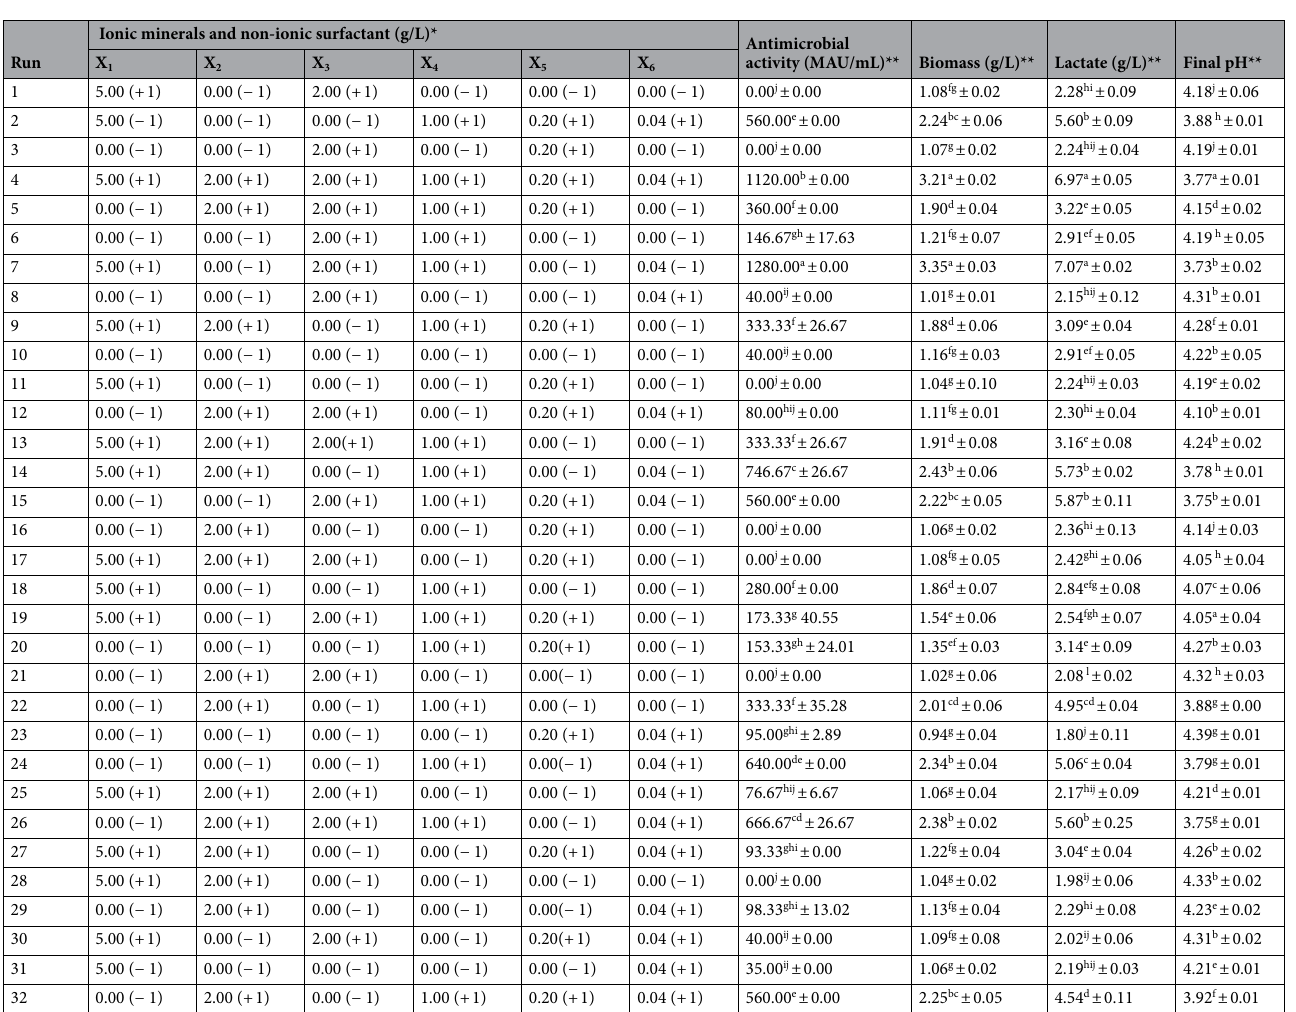
Table 4. FFD matrix with coded and real values of ionic minerals, non-ionic surfactant and their corresponding effects on the antimicrobial activity, lactate concentration and pH of postbiotic RS5, and